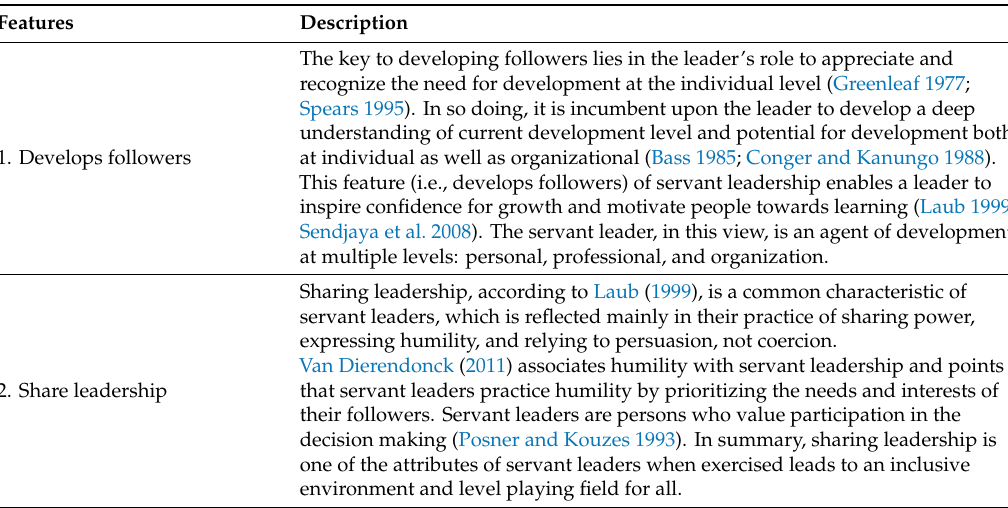
Table 1. Describes the six features describing servant